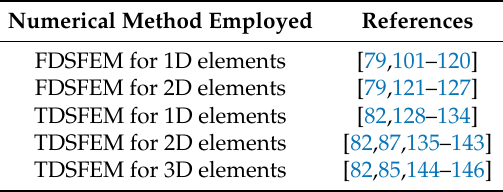
Table 2. Synthetic compilation of research papers devoted to numerical modelling of different structural elements for wave propagation